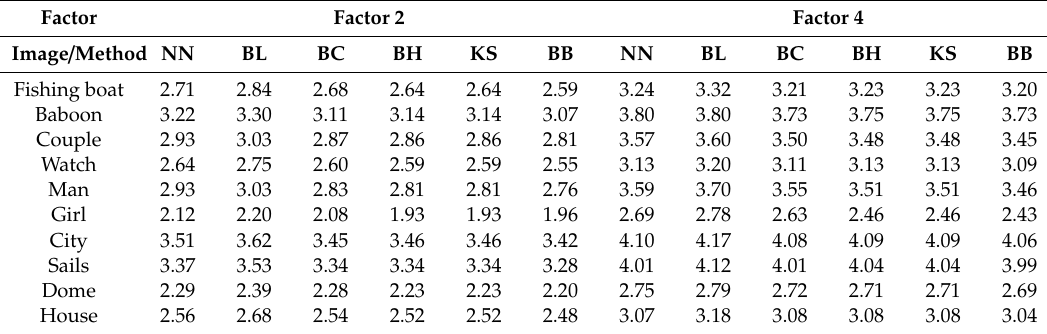
Table 9. Comparison results in terms of root mean square error (RMSE).